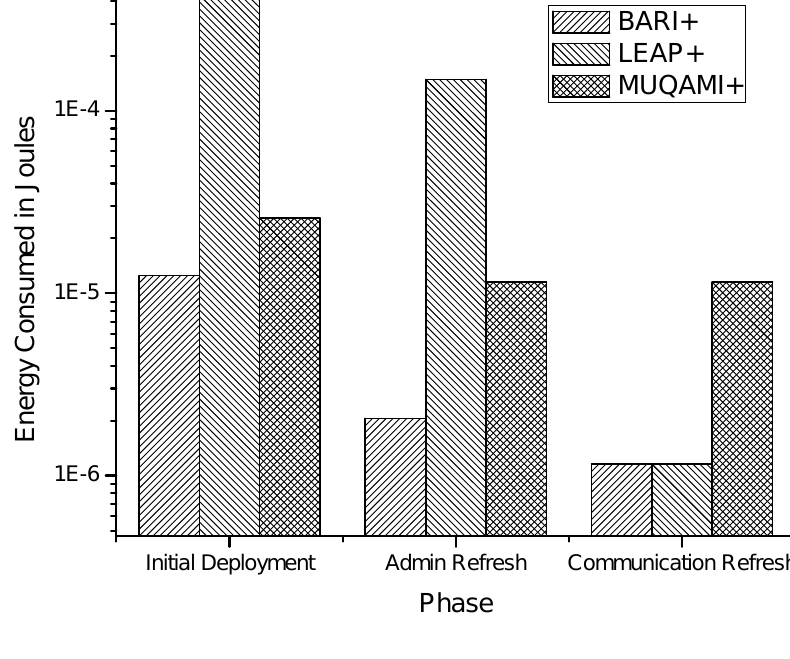
Figure 4. Comparison of Average Energy Consumed by a Sensor Node in different phases of each